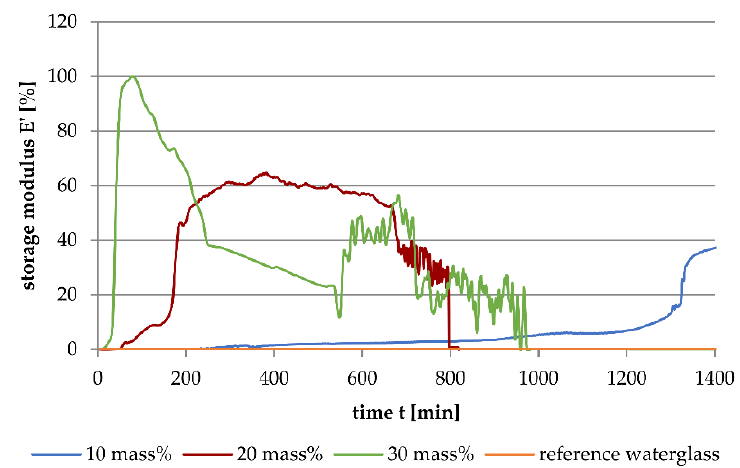
Figure 2. DMA measurements of the waterglass samples with different added content of BPO 4 hardener at T A = 25 °C. The reference is a waterglass sample without any hardener added.